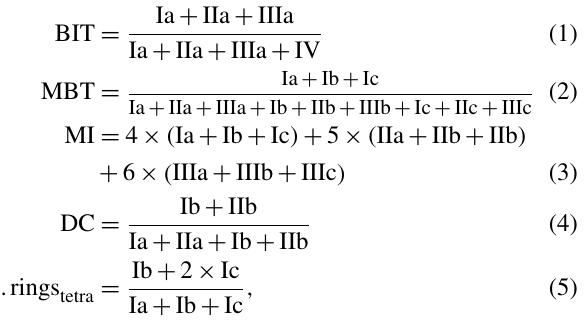
of Hopmans et al. (2004), Weijers et al. (2007b), Zhang et al. (2011), Sinninghe Damsté et al. (2009) and Sinninghe Damsté (2016),